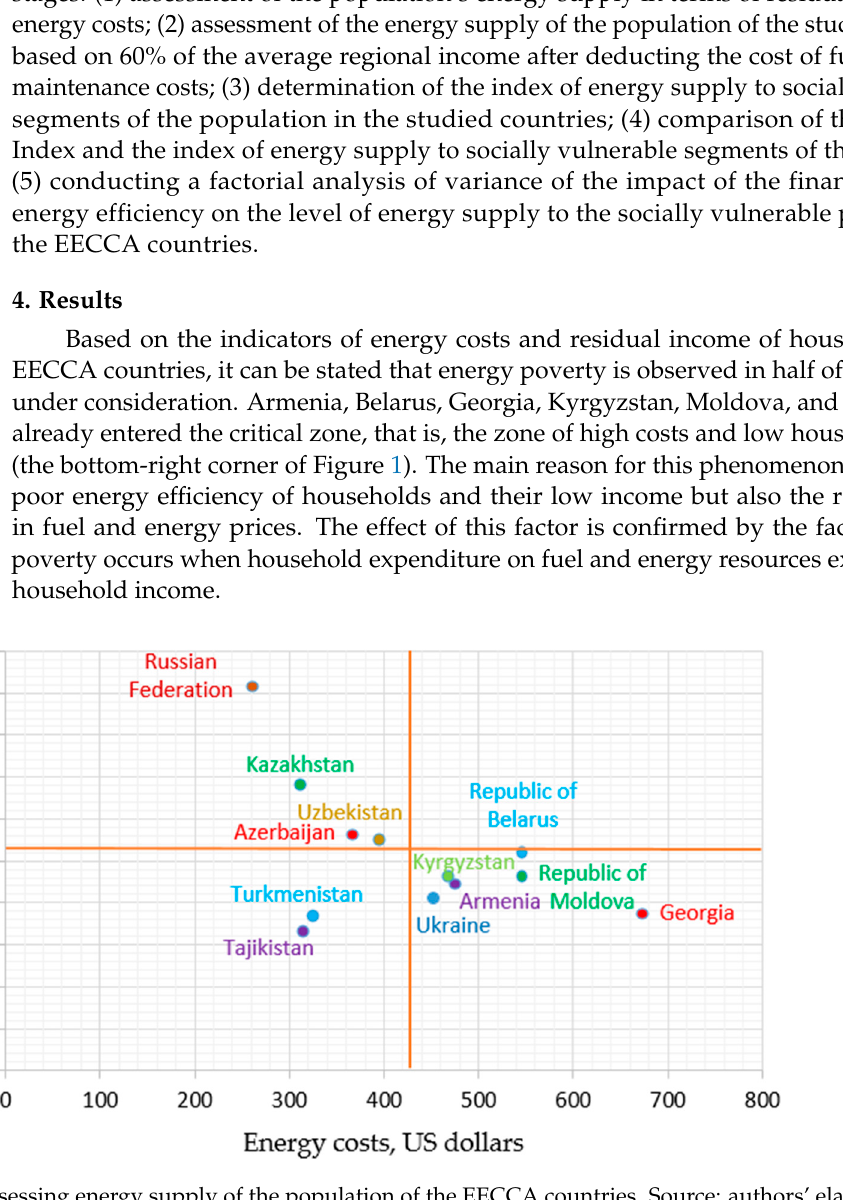
Table 1. Initial data for the analysis of variance of the impact of financial risk and energy efficiency on the level of energy supply to socially vulnerable groups of EECCA countries’ population (fragment).